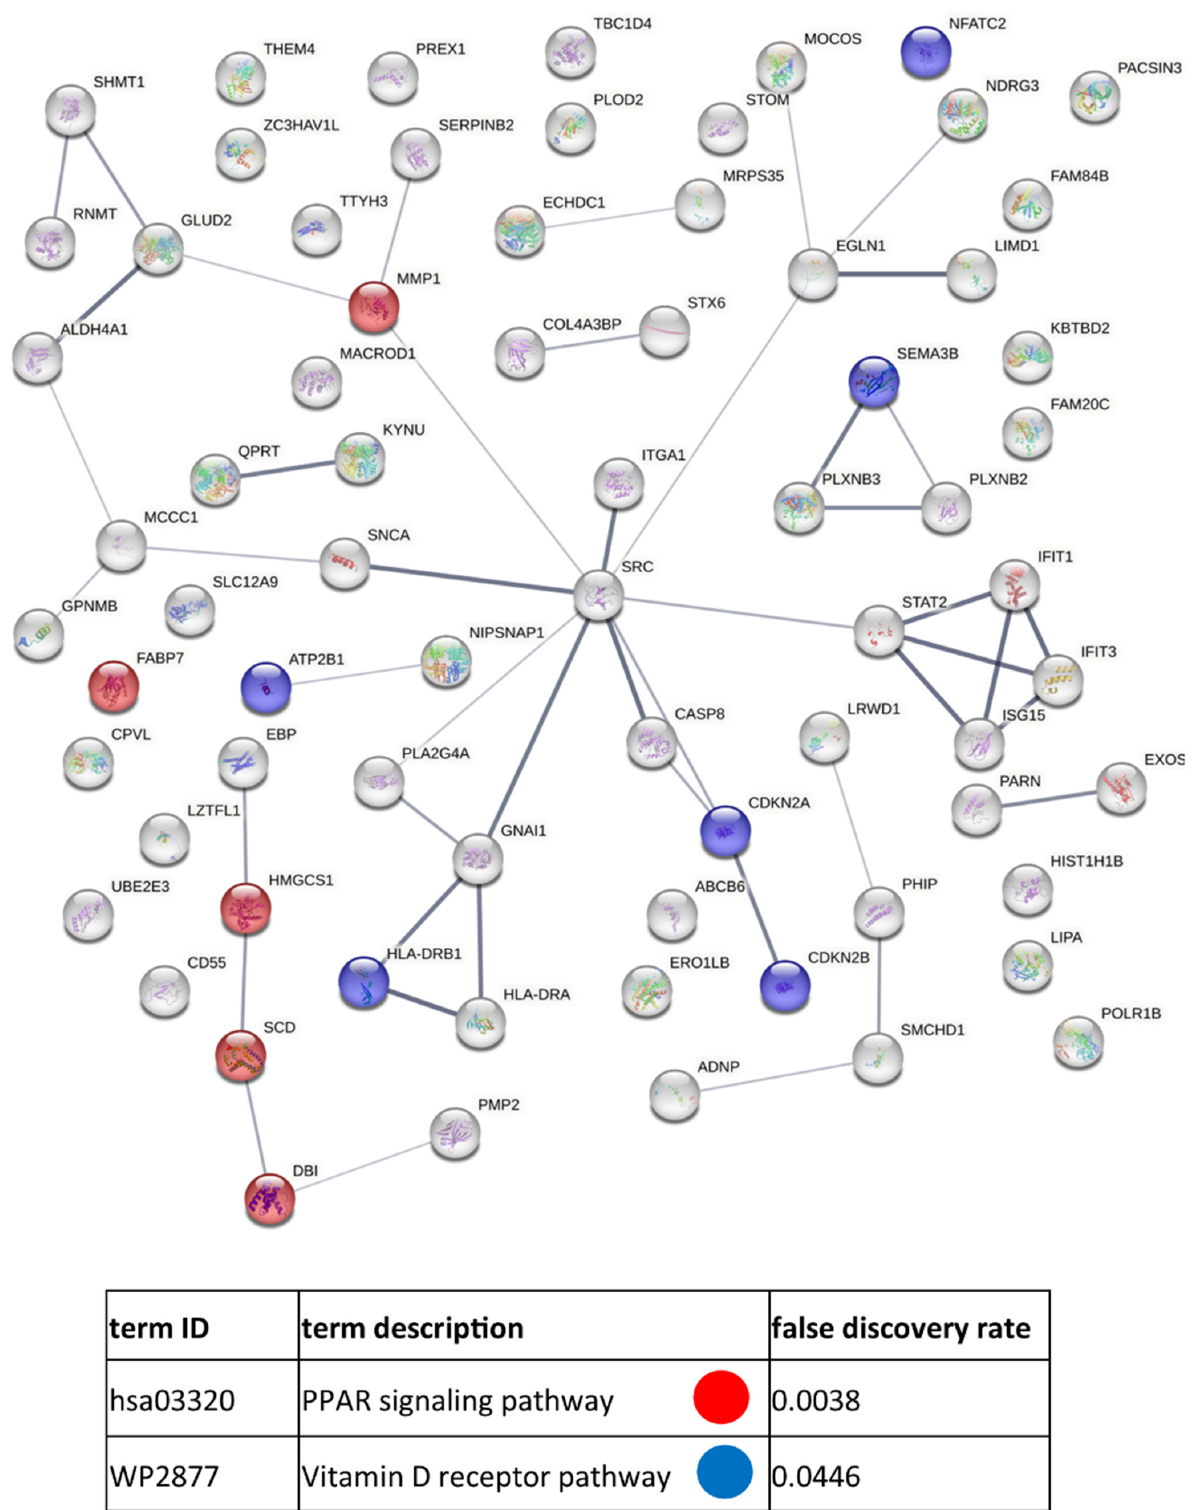
Figure A2. Diagram of functional protein association networks prepared with the use of STRING v. 11.0 software for proteins identified in WM793 cells but not found in any replicates of WM1205Lu cells. The selected, strongly represented pathways are presented as an interactome. A complete analysis is presented in Supplementary Data S3.